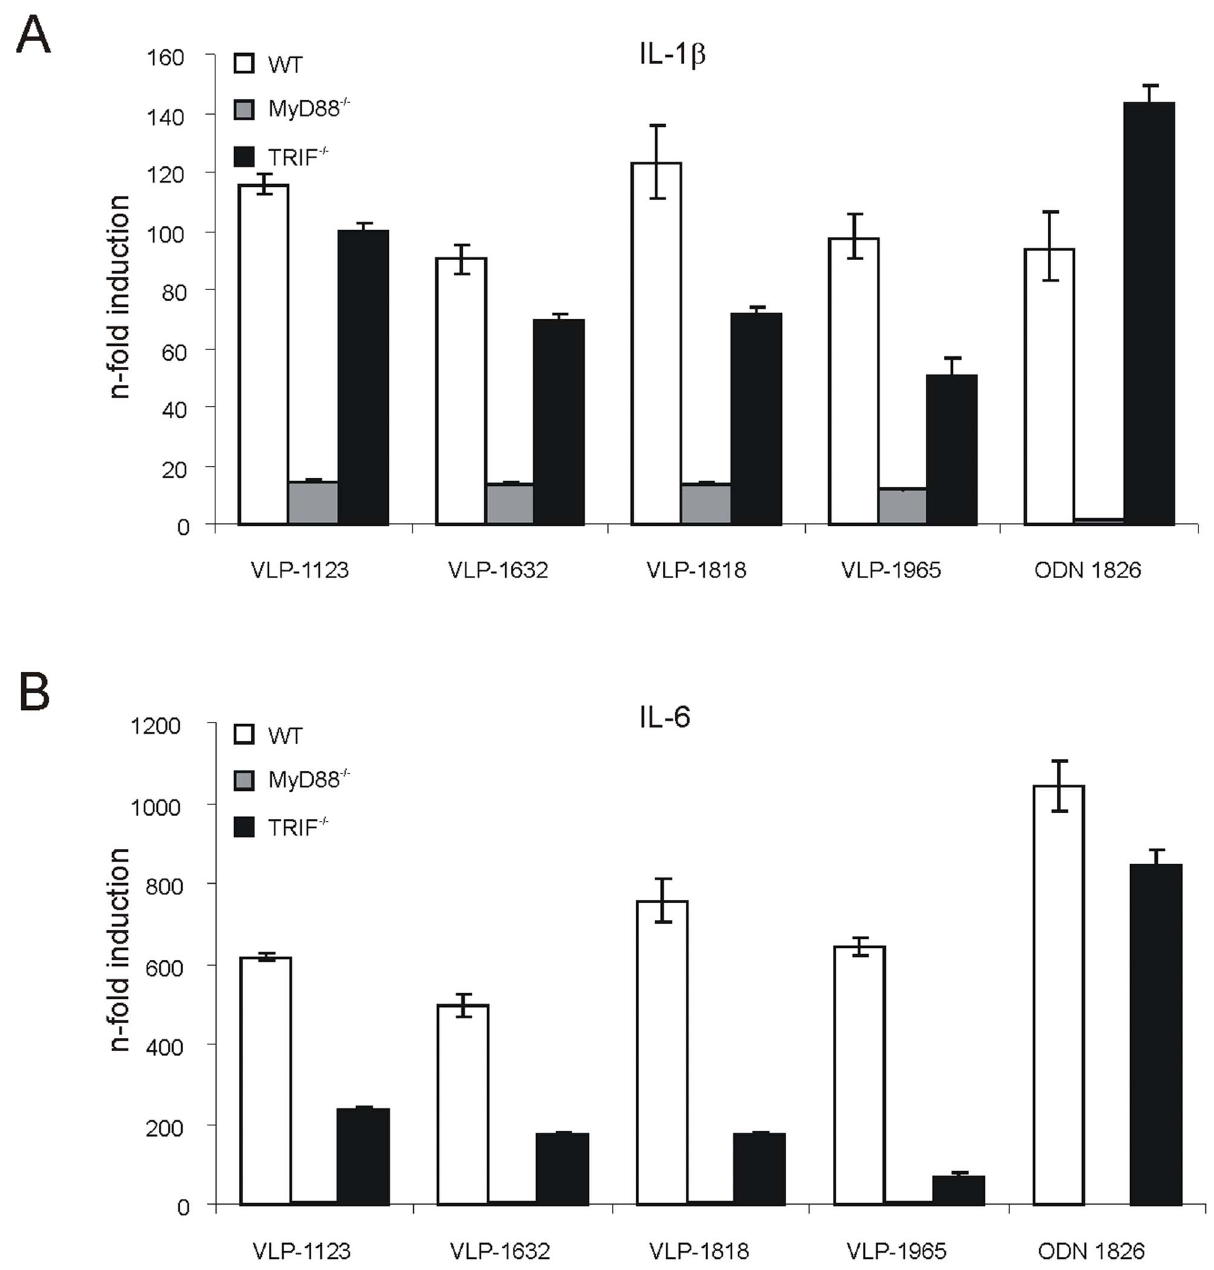
Figure 4. VLP-associated nucleic acids signal through MYD88 and TRIF. RT-qPCR was used to analyze mRNA expression levels of the pro- inflammatory cytokines IL-1 b and IL-6 20 hours after stimulation of WT, MyD88 2 / 2 or TRIF 2 / 2 DCs with 20 m g of VLP-1123, VLP-1632, VLP-1818, VLP- 1965 or 1 m g of ODN 1826. Results represent mean n-fold induction levels compared to unstimulated control cells 6 SD from triplicate PCR reactions.